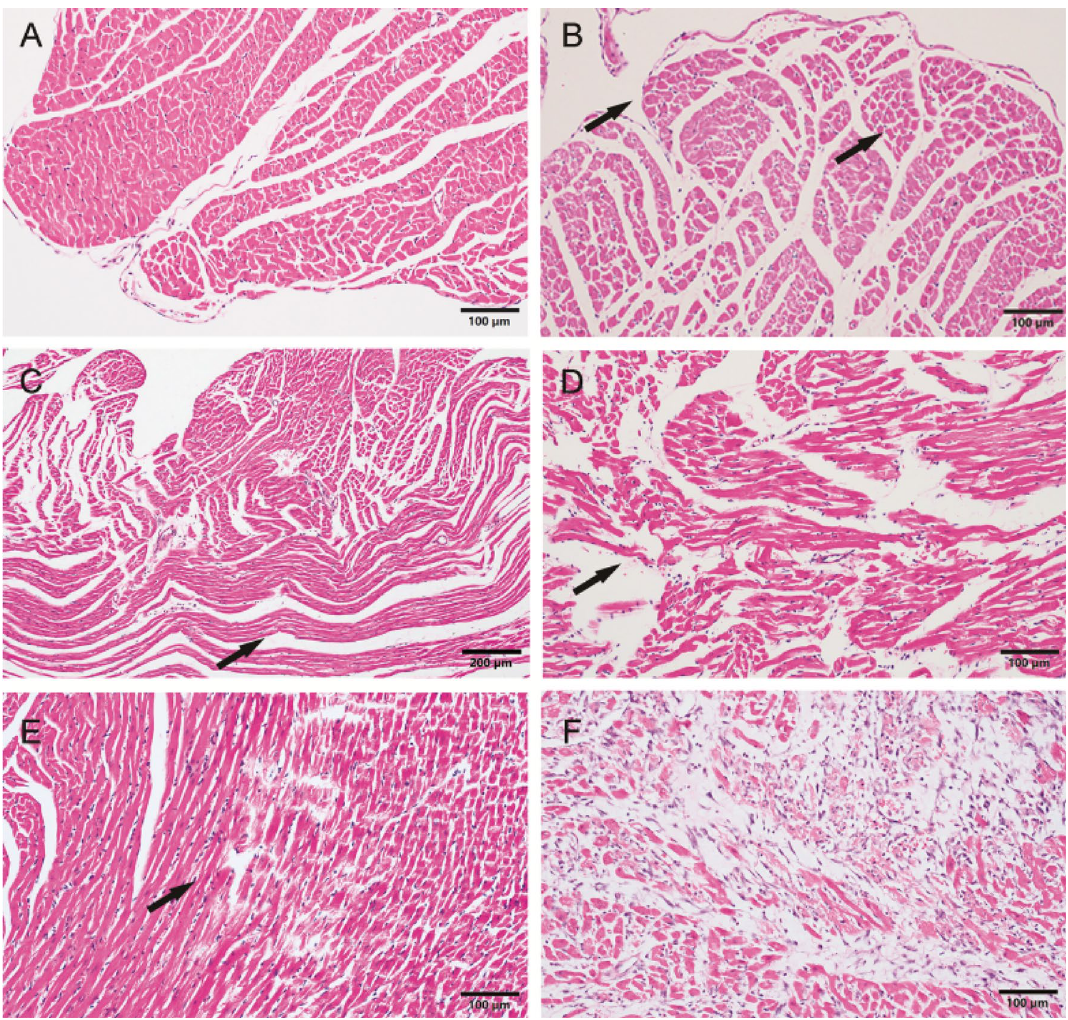
Figure 2. Haematoxylin–eosin (H-E) staining of the rat myocardium. ( A) Normal rat left ventricular myocardium. (B) The left ventricular myocardium showed myocardial enhanced eosinophil staining (arrows) after 10 min of arrhythmia. (C) Enhanced eosinophil staining (arrow) was shown in the left myocardium after 10 min of arrhythmia in rat. (D) Myocardial wavy-like (arrow) was shown after 30 min of arrhythmia in rats. (E) Myocardial necrosis (arrow) with haemorrhage and contraction bans was shown after 60 min of CAL. (F) Coagulation necrosis with loss of nuclei and striations, interstitial infiltrate of neutrophils was shown after 2 consecutive-days injections of ISO model of VA induced by BaCl 2 solution was successfully established in rats. In coronary artery ligation (CAL) rat models, after ligation of left coronary artery (LCA), the ST segment elevation was observed by ECG tracings, indicating the success of model construction (Fig. 1E). After injection of isoproterenol (ISO) solution for 2 con- secutive days, the ECGs of rats showed changes in myocardial infarction (Fig. 1F). Histologic changes in the rat myocardium. We randomly selected three animals from each group in IHD models for histological examination, and the proportion of animals in IHD models that underwent histological examination was 84/170. The normal left ventricular myocardium of rats was shown in Fig. 2A. Enhanced eosinophil staining (Fig. 2B) and myocardial wavy-like (Fig. 2C) were the two most common nonspe- cific ischemic findings (proportion was 40/84 and 35/84, respectively) in rat myocardium Haematoxylin–eosin (H–E) staining of three acute IHD models. Myocardial interstitial haemorrhage (Fig. 2D) could be observed in the myocardium of rats with long period of arrhythmia and CAL (proportion: 9/84). After 3 h of coronary liga- tion, myocardial necrosis with hemorrhage and contraction bans (Fig. 2E) could be observed (proportion: 3/84). After injections of ISO solution for 2 consecutive days, gray-white infarcts were shown in the apex of rat hearts. Coagulation necrosis (Fig. 2F) with loss of nuclei and striations, interstitial infiltrate of neutrophils was shown in light microscopy (proportion: 3/14).